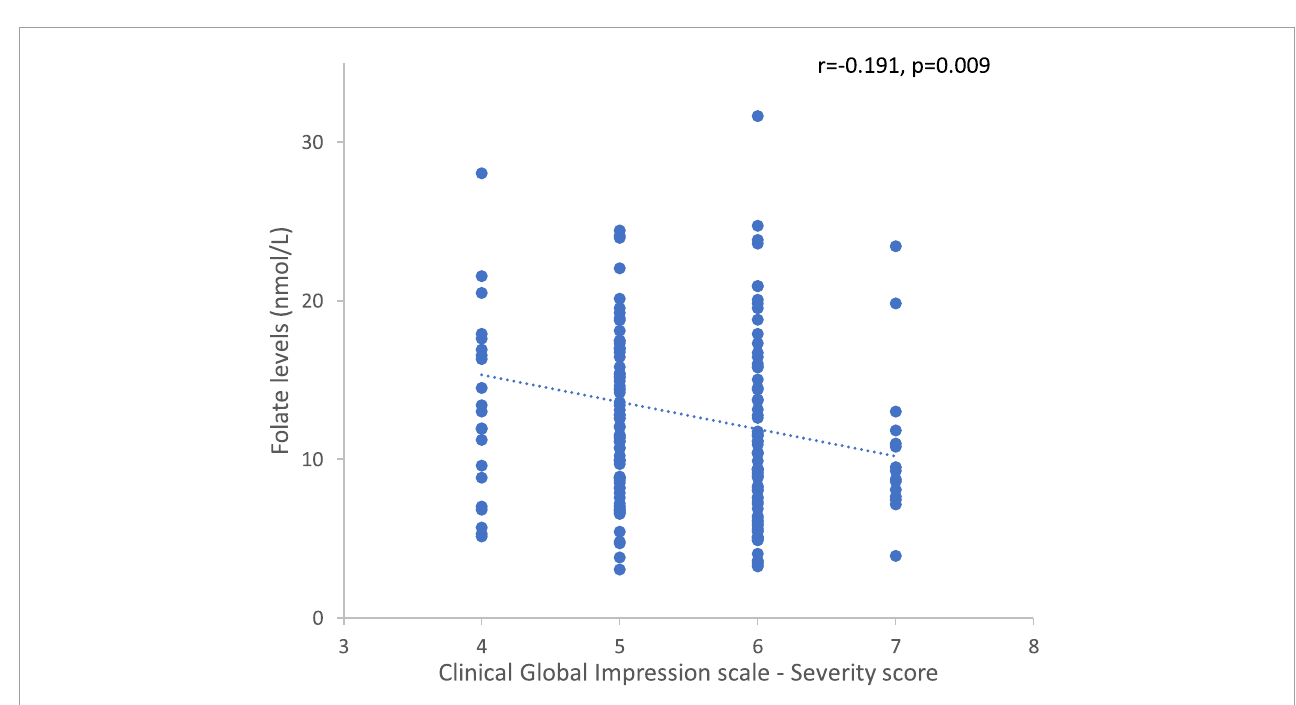
FIGURE7 Correlation between folate levels and the Clinical Global Impression – Severity scores in the whole